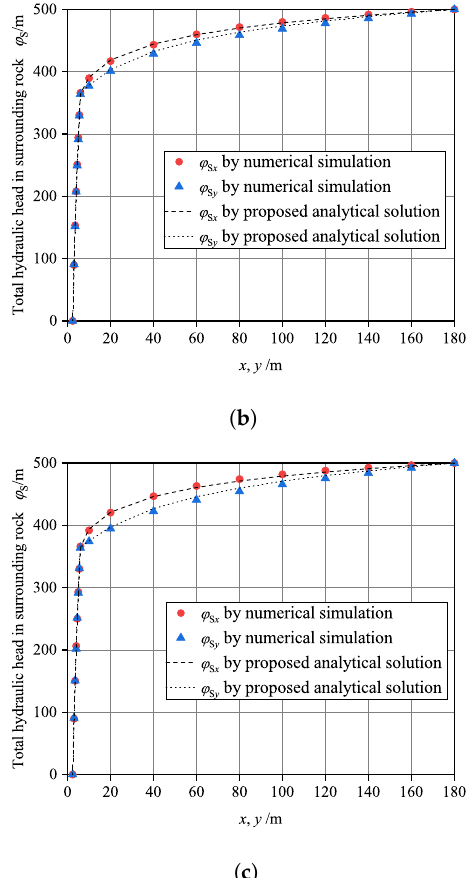
Figure 5. Total hydraulic head along coordinate axis. ( a ) n = 1. ( b ) n = 2. ( c ) n =